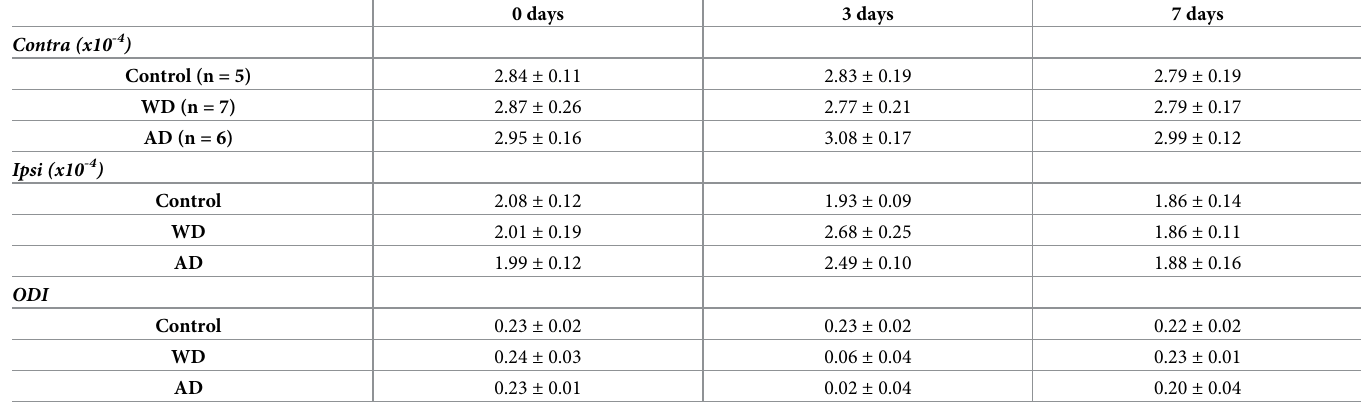
Table 1. The effects of WD and AD on V1 responsiveness and OD. Data are presented as means ± s.e.m.